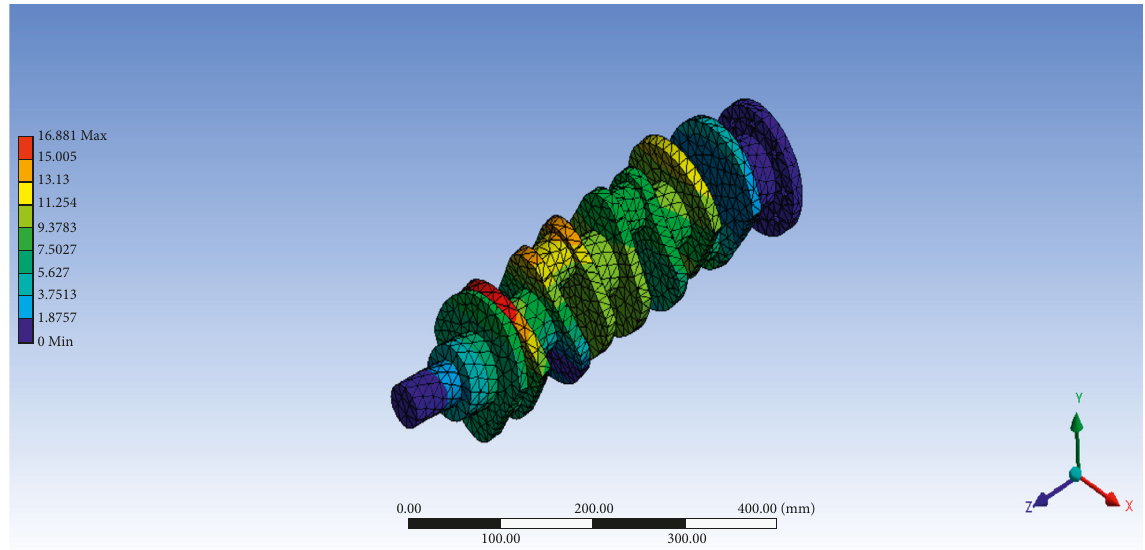
Figure 13: Deformation of carbon fiber composite crankshaft at the third mode of